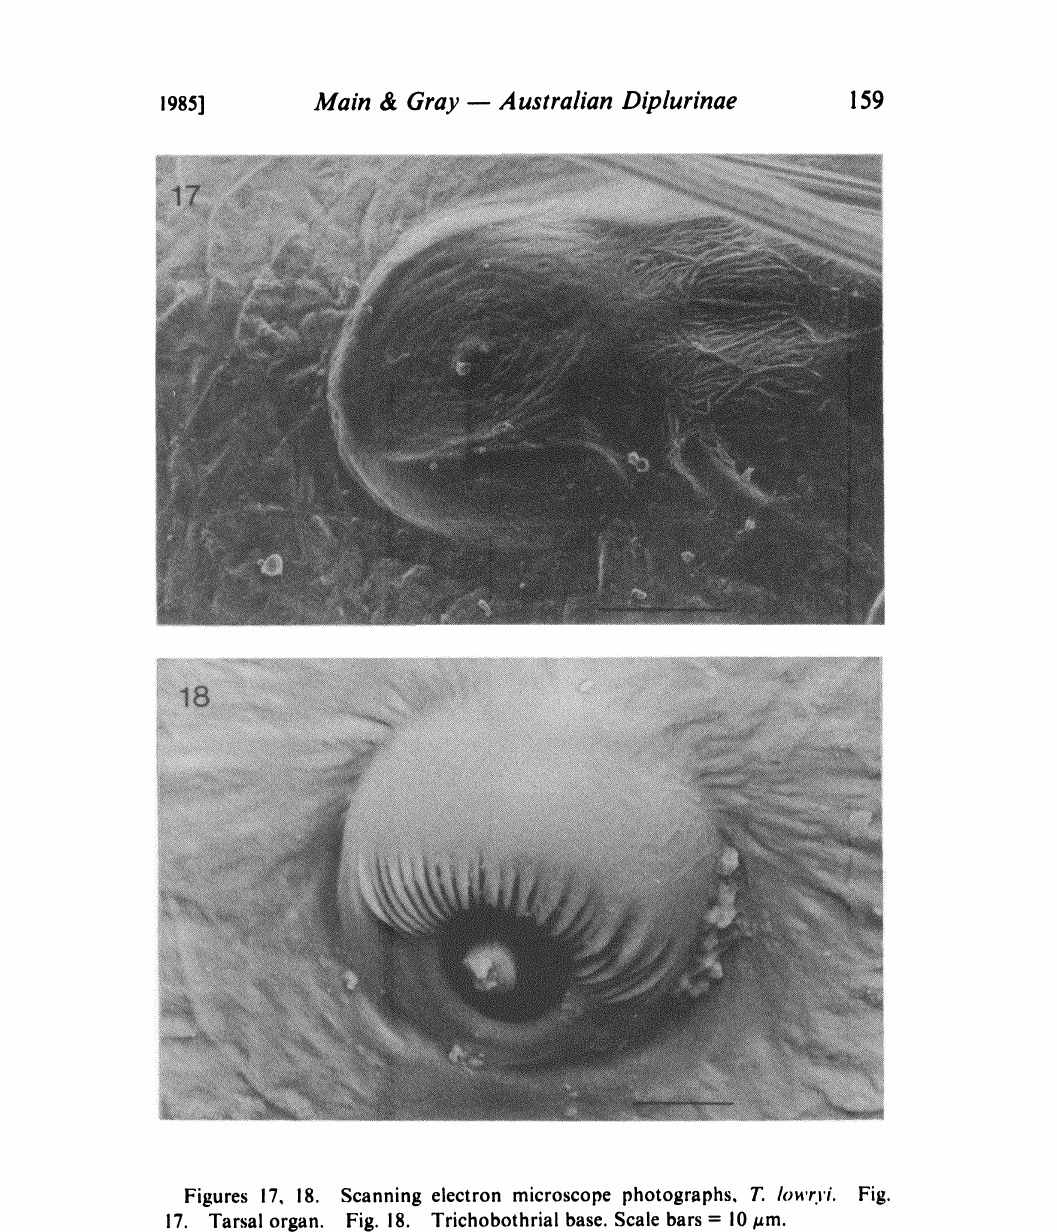
Figures 17. 18. Scanning electron microscope photographs. T. Iowr.vi. Fig. 17. Tarsal organ. Fig. 18. Trichobothrial base. Scale bars